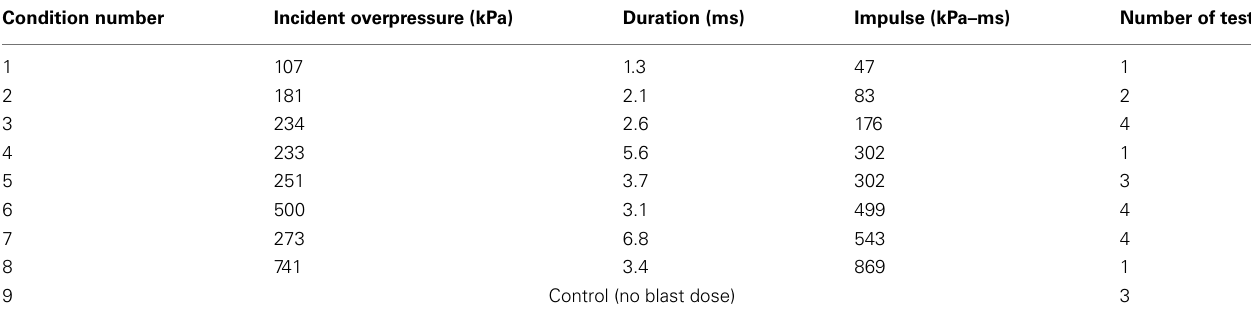
Table 1 |Test matrix of shock conditions and number of repeated tests.